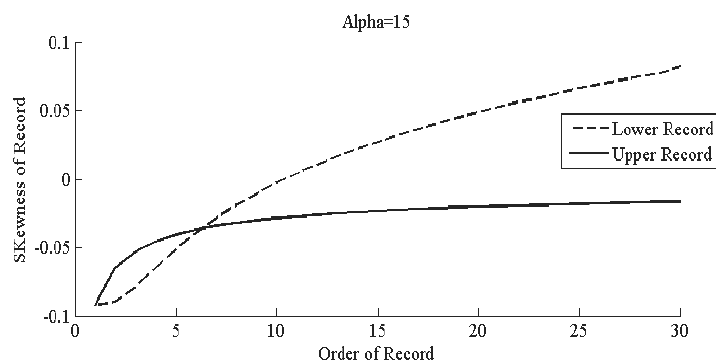
Figure 17 – Skewness coefficient of